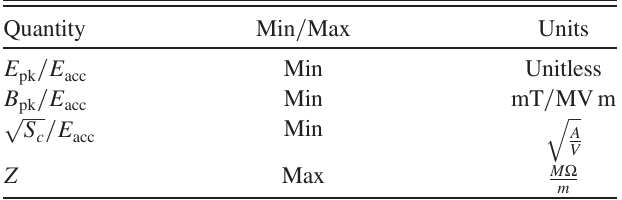
TABLE I. Optimization